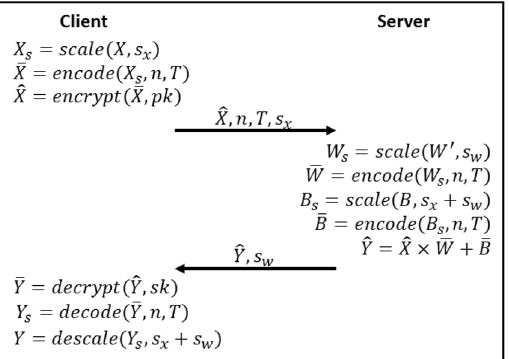
· denotes encrypted (cid:31)